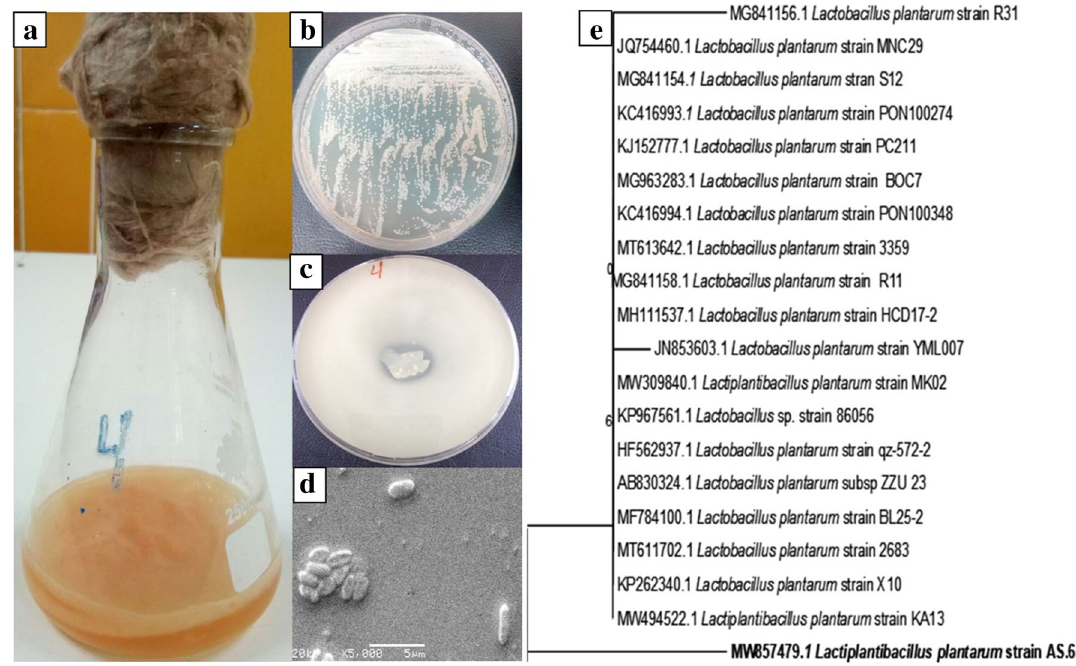
Figure 2. Eye observation of BC ( a ), purified and separate colony ( b ), acid production ( c ) and SEM ( d ) and phylogenetic tree based on 16S rDNA sequences ( e ) of L. plantarum